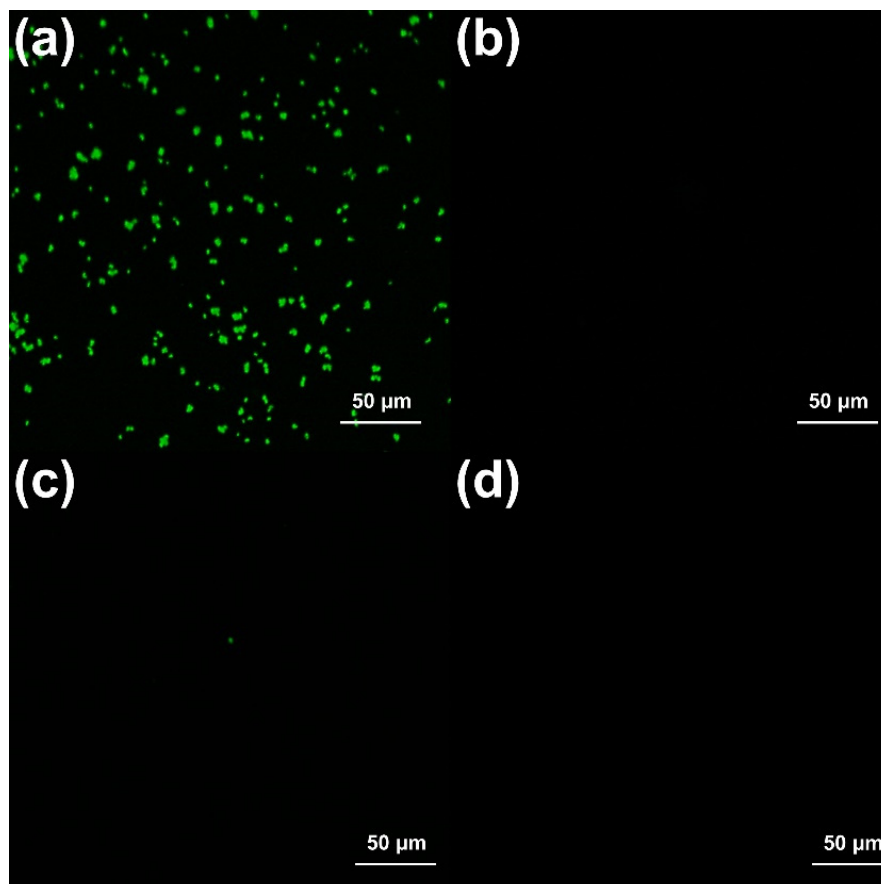
Figure 5. Confocal laser scanning microscope images of S. aureus accumulated on the ( a ) bare agarose hydrogel, ( b ) PeptoidCB 24 -1 hydrogel, ( c ) PeptoidCB 49 -1 hydrogel, and ( d ) PeptoidCB 69 -1 hydrogel.